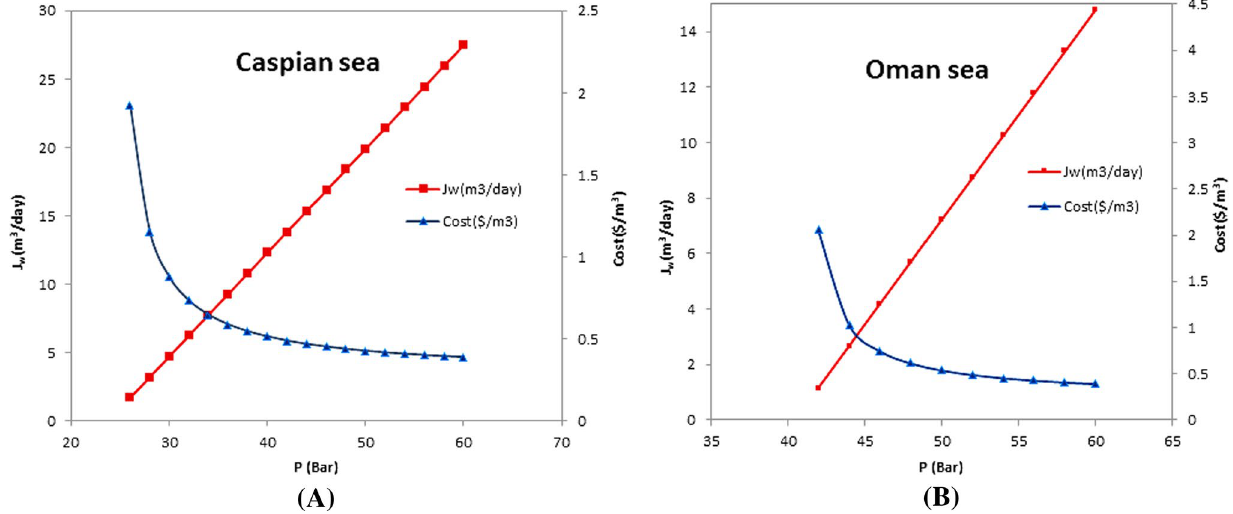
Fig.4 Evaluating the applied pressure on the cost of product water and the permeate flow rate from the